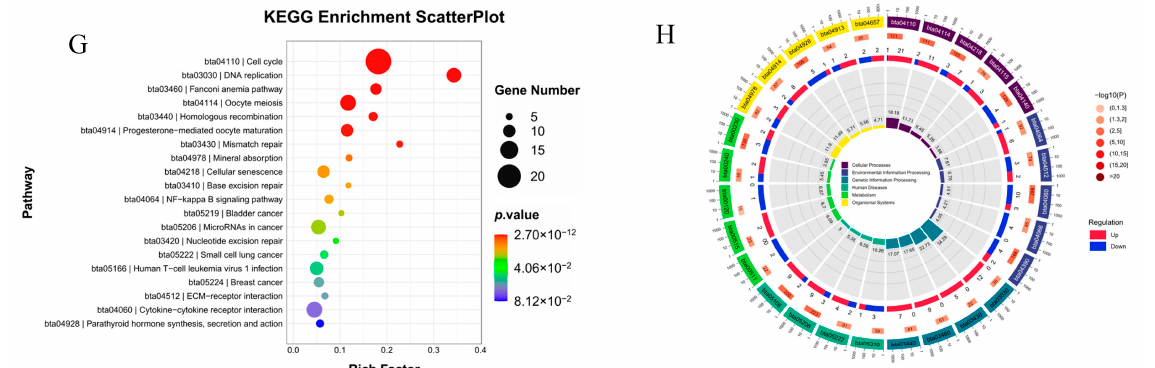
Figure 4. Identification and enrichment analyses of DEGs associated with lncBNIP3. ( A ) PCA Plot; ( B ) Pearson correlation coefficient cluster graph; ( C ) The number of up-regulated and down-regulated DEGs; ( D ) Heatmap for hierarchical cluster analysis of all sequencing samples and DEGs; ( E ) Volcano plot for the distribution of DEGs; ( F ) GO enrichment analysis results for DEGs; ( G ) KEGG enrichment analysis of DEGs; ( H ) Cyclic plots of the number of up-regulated and down-regulated DEGs in different enrichment pathways.